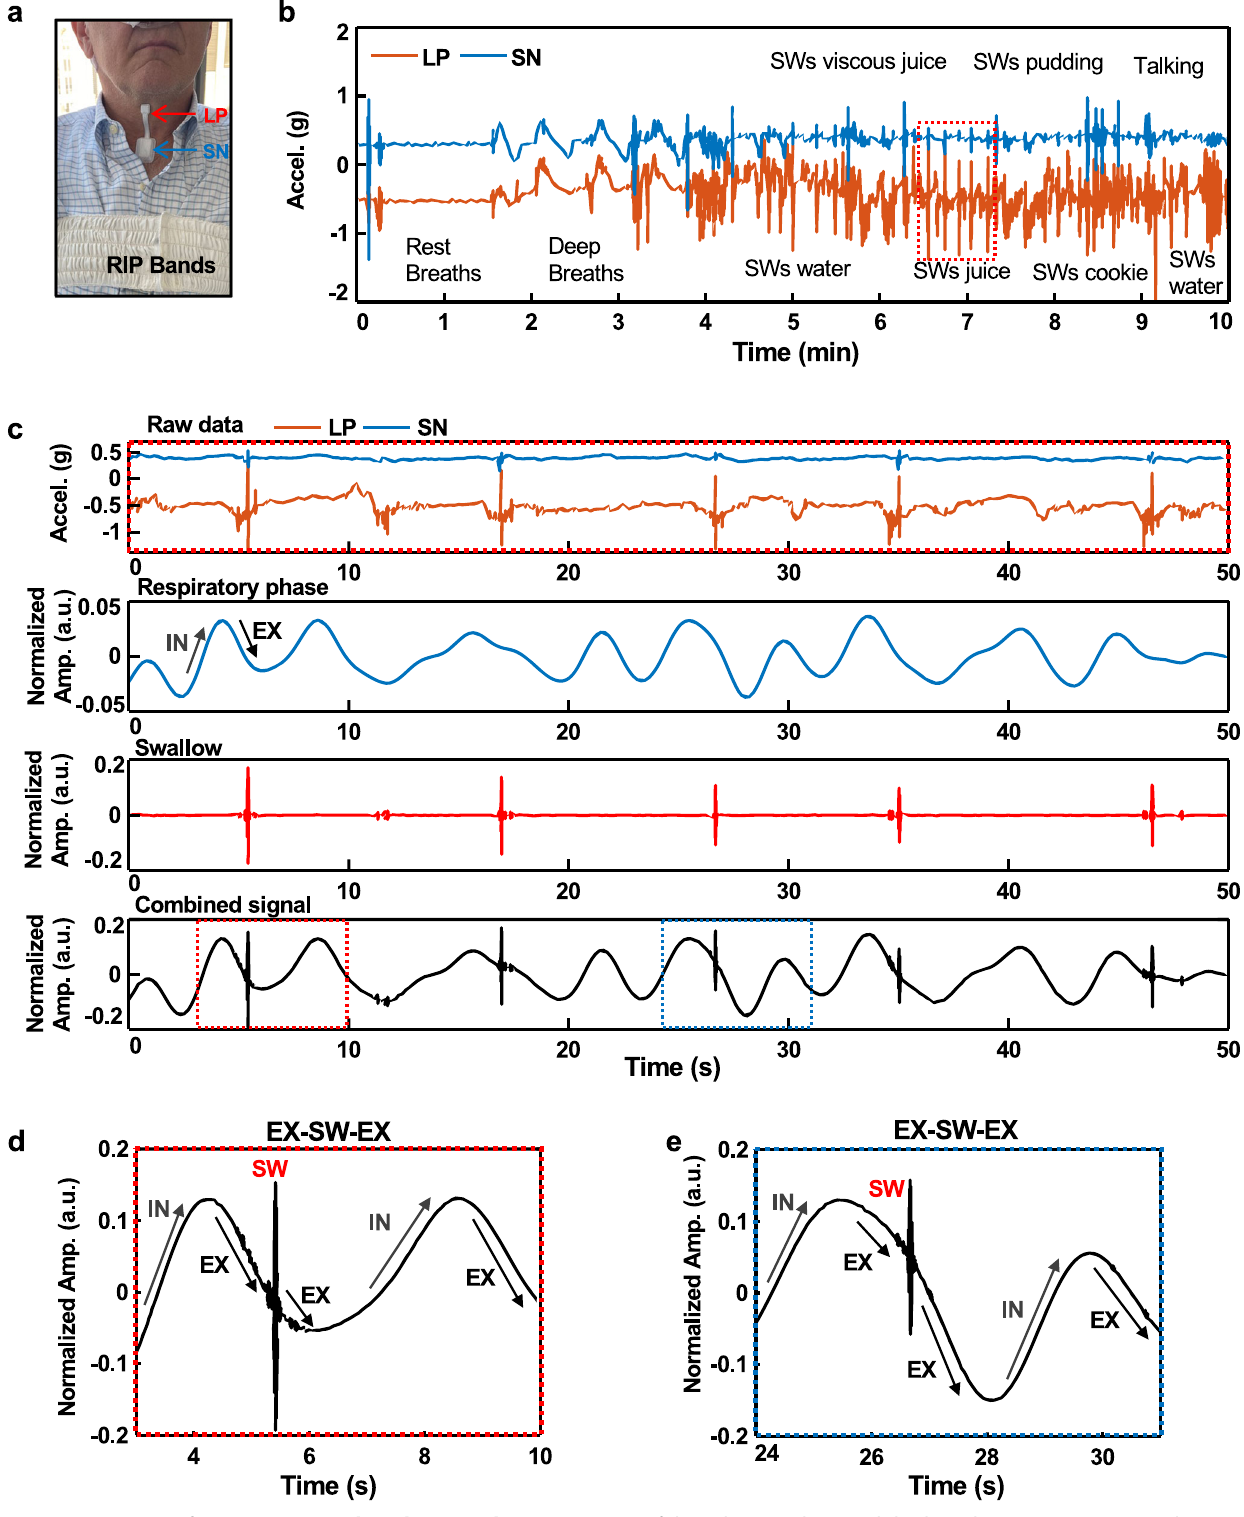
Fig. 4 Measurements from a patient with Parkinson ’ s disease. a Image of the subject with an umbilical mechano-acoustic (UMA) device and RIP bands. b Raw data from the UMA device, corresponding to accelerations measured at the SN (blue) and LP (orange). The activities illustrated here include three different respirations followed by swallows associated with various liquids and food. c Graphs from top to bottom show data: unprocessed, corresponding to swallowing of juice as illustrated in the red dashed box of the frame a ; bandpass fi ltered between 0.1 and 0.8 Hz; high pass fi ltered at 90 Hz; combined, fi ltered data to highlight swallowing and respiration. d , e Data corresponding to the regions highlighted by the red and blue dashed boxes in the bottom graph of frame c